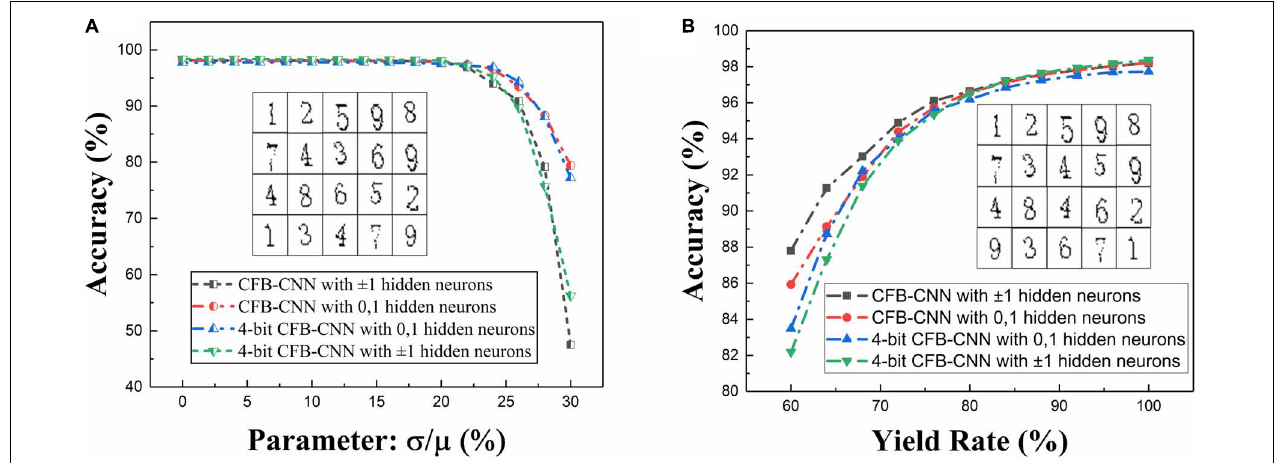
FIGURE 8 | Impacts caused by different types of defects on 01 MD and 4-bit-01 MD or ± 1 MD and 4-bit ± 1 MD, (A) recognition rate of CFB-CNN architecture on MNIST dataset with memristance variation varying from 0 to 30%, (B) recognition rate of CFB-CNN architecture on MNIST dataset when damaged device rate is varying from 0 to